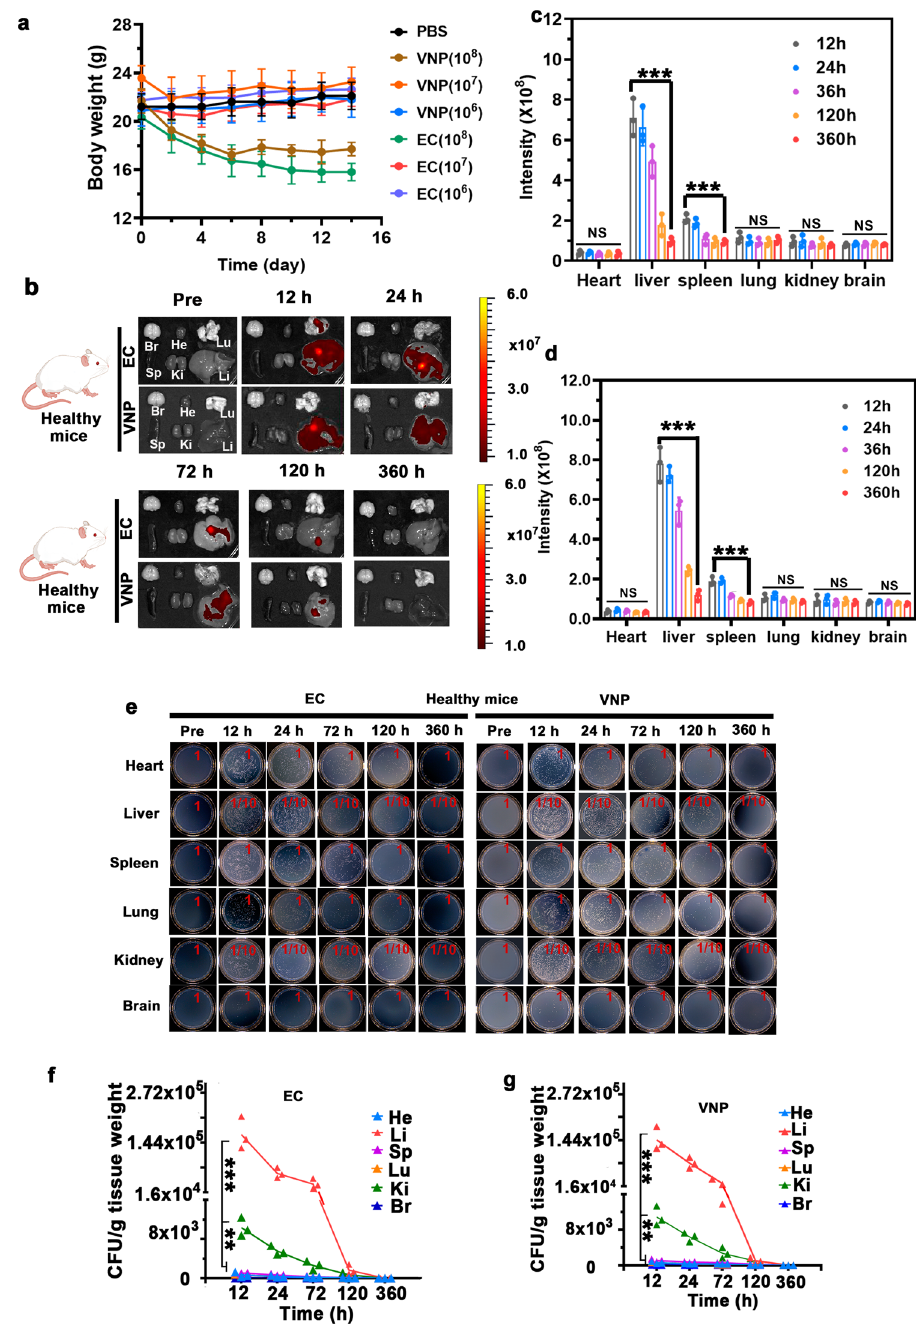
Fig. 4 | In vivo behaviors of bacteria in mice. a Average body weights of healthy mice injected with EC or VNP with different concentrations. Data are presented as meanvalues+/ − SD( n =3). b – d Exvivo fl uorescenceimagesofmajororgans(heart, liver,spleen,lung,kidney,andbrain)ofhealthymiceaftertheintravenousinjection withmCherry@ECandmCherry@VNPatthedoseof~1×10 7 CFUfor12,24,72,120, and 360h ( b ) and corresponding fl uorescenceintensity in mCherry@ECgroup ( c ) and mCherry@VNP group ( d ). *** p =8.81×10 − 6 for 360h vs. 12h (liver), *** p =3.28×10 − 4 for 360h vs. 12h (spleen) ( c ). *** p =2.98×10 − 7 for 360h vs. 12h (liver), *** p =9.77×10 − 6 for 360h vs. 12h (spleen) ( d ). Data are presented as mean